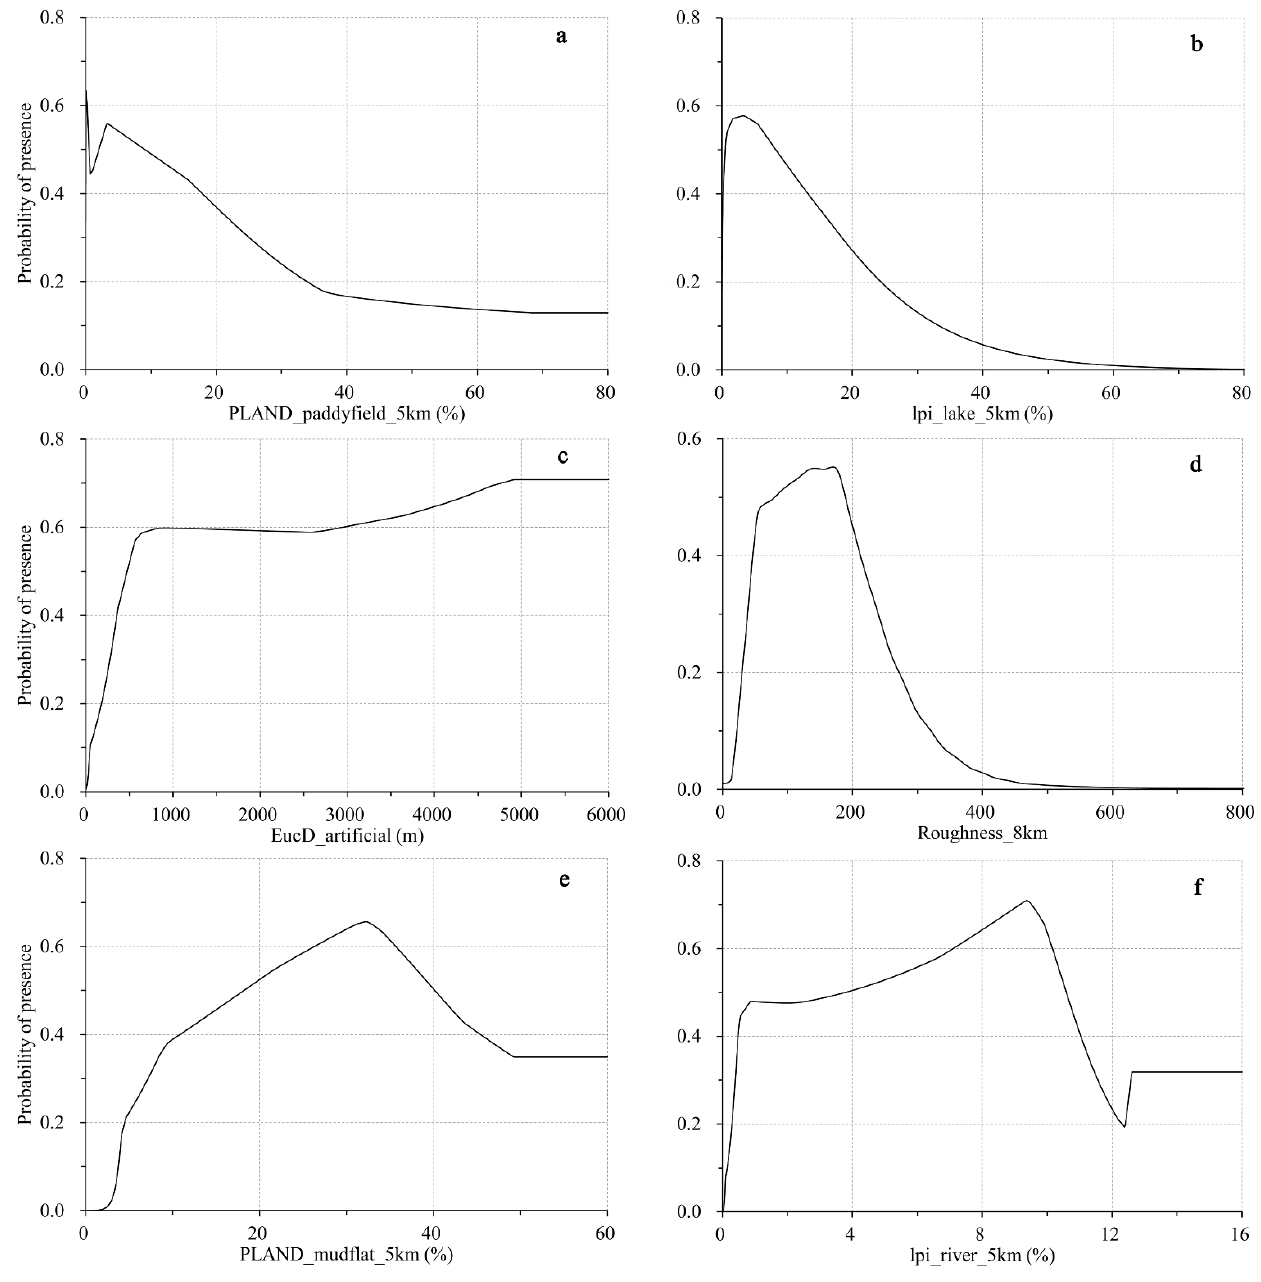
Figure 4. Response curves of top ranked variables for foraging: ( a ) PLAND of paddyfield at the 5-km scale, ( b ) LPI of lake at the 5-km scale, ( c ) distance to artificial surfaces, ( d ) surface roughness at the 8-km scale, ( e ) PLAND of mudflat at the 5-km scale and ( f ) LPI of river at the 5-km scale.